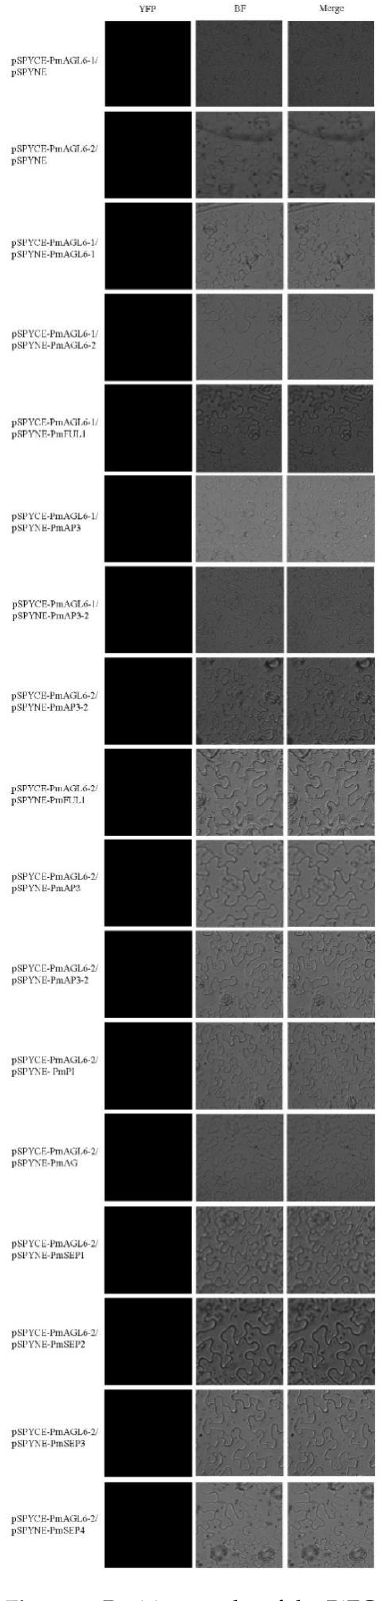
Figure 7. Positive results of the BiFC analysis of protein–protein interactions among the products of the two AGL6 genes and other floral organ identity-determining genes in P. mume . YFP: yellow fluorescent protein, BF: bright-field image, merged: merged YFP and BF images.